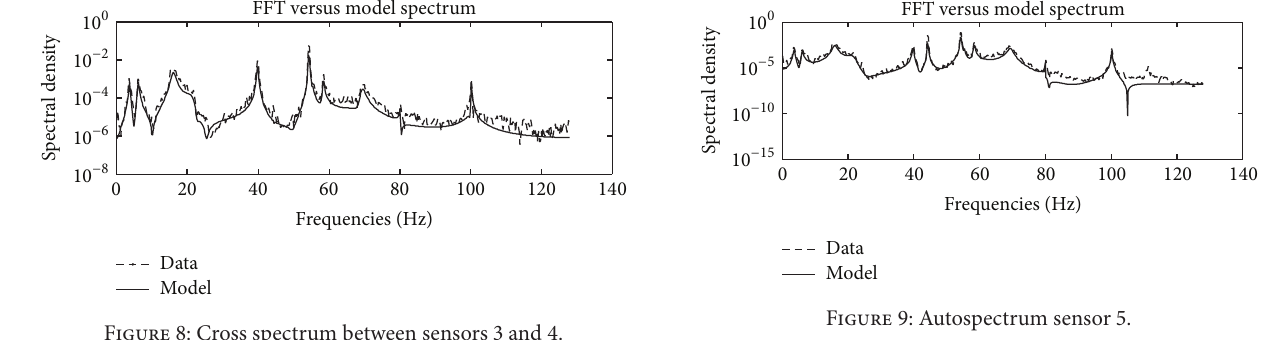
Figure 8: Cross spectrum between sensors 3 and 4.